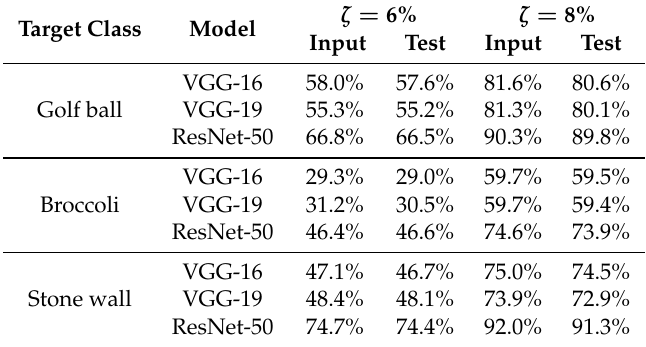
Table 1. Targeted attack success rates r ts of targeted UAPs against the DNN models for each target class. r ts for input images and test images are shown.